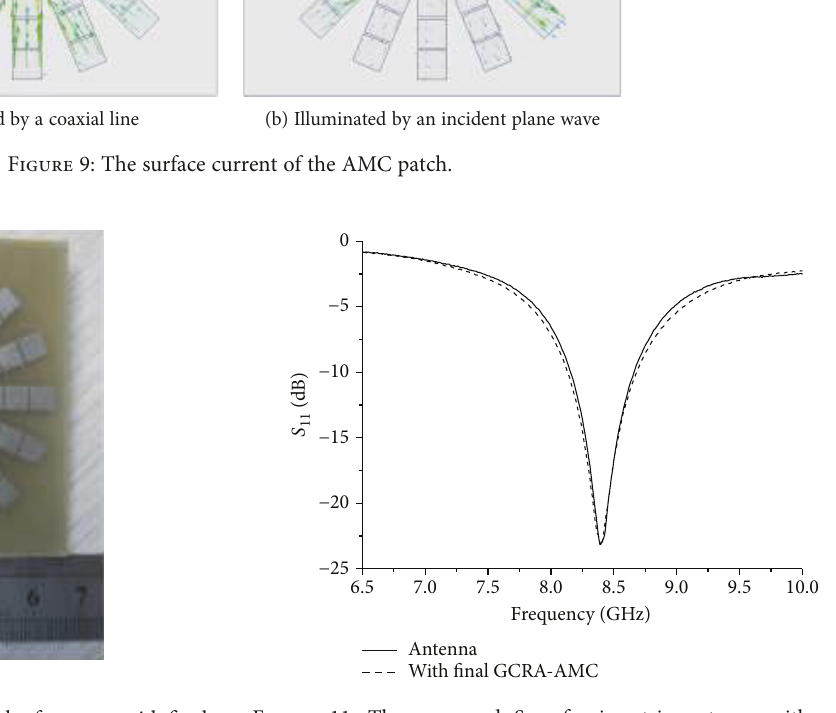
of microstrip antenna with and 11